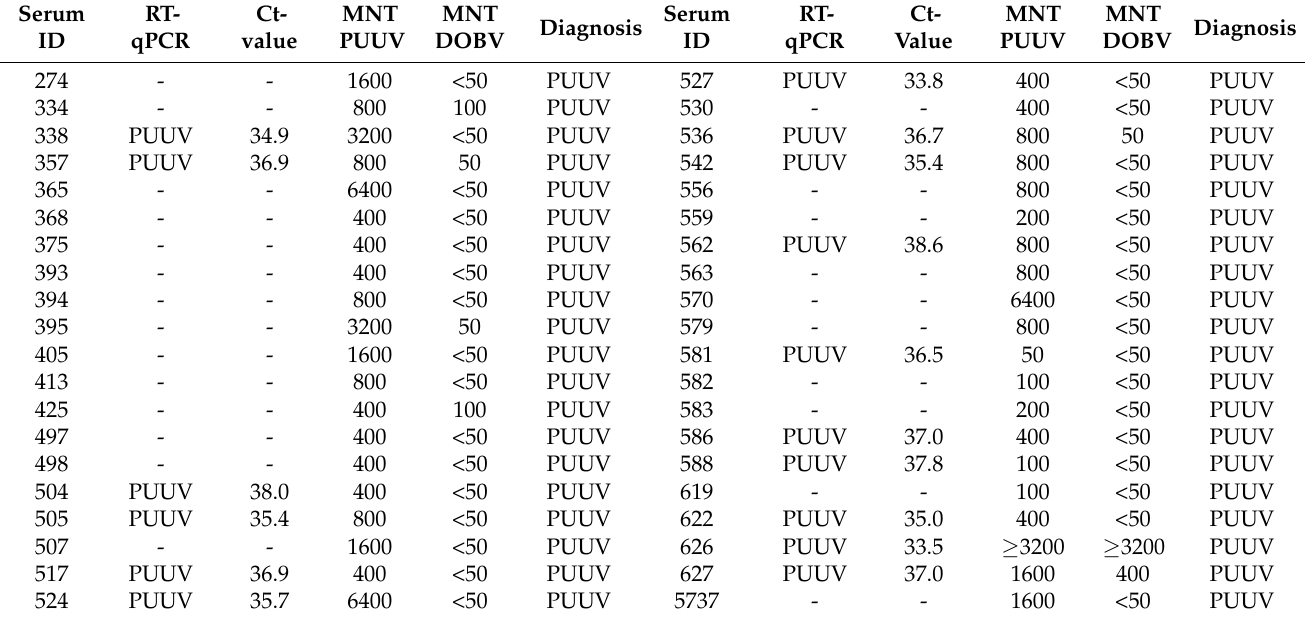
Table 2. Retrospective diagnostics of patient sera. Detectable Ct-values (<40) for PUUV RNA- confirmed PUUV diagnosis. In addition, the presence of PUUV-neutralizing titers determined during micro-neutralization test (MNT) with the absence of DOBV MNT titers or four-fold higher PUUV MNT titers also confirmed PUUV diagnosis. Serum 626 was not tested to higher dilution in MNT due to limited sample availability. Abbreviations: ID, identity; RT-qPCR, quantitative reverse